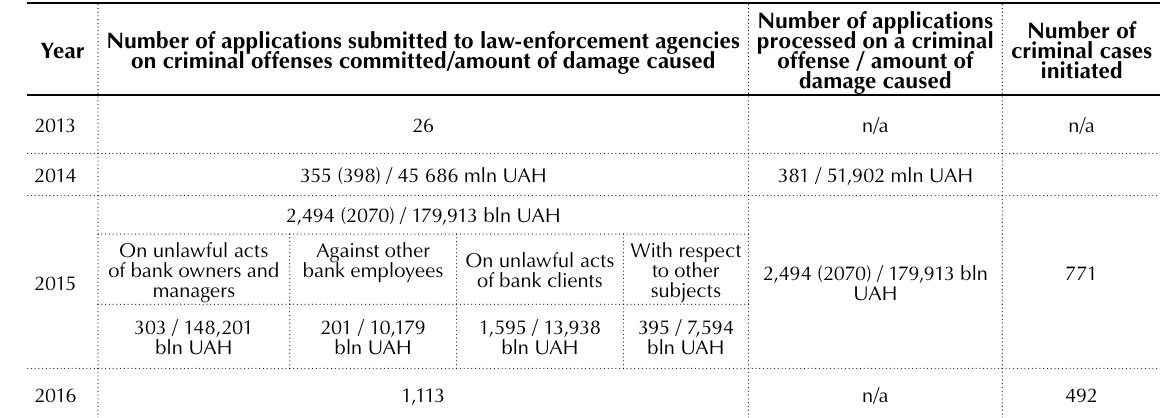
Table 1. Data on the number of criminal offenses in banking for 2013–2016 period according to the Deposit Guarantee Fund annual reports Number of applications submitted to law-enforcement agencies Year on criminal offenses committed/amount of damage